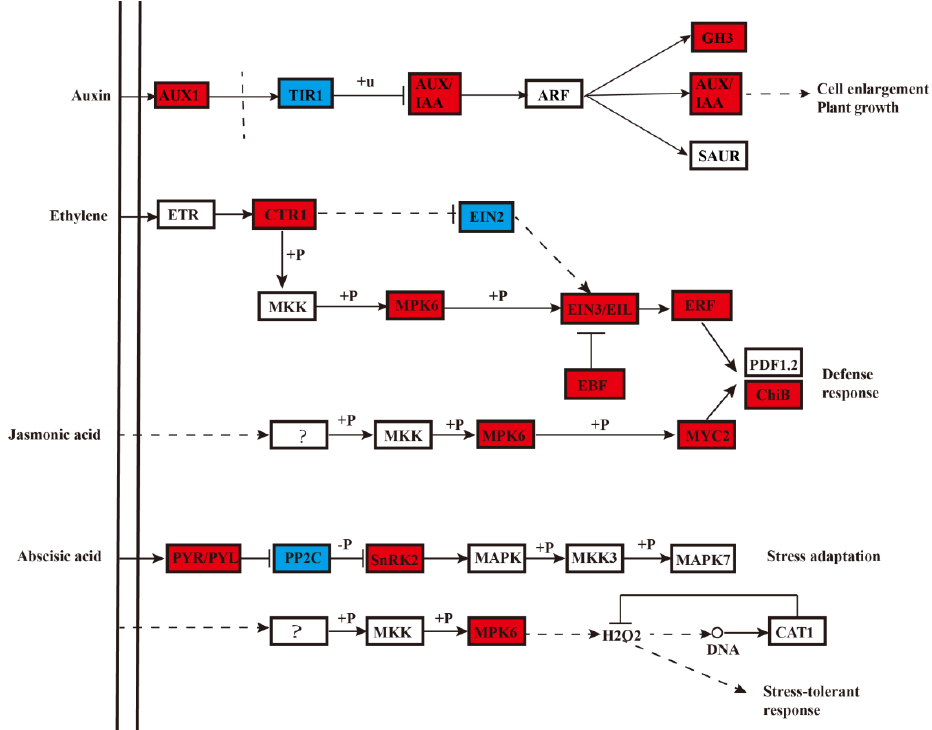
Figure 3. Expression profiles of genes related to hormone signaling. Red boxes indicate genes upregulated after cold storage; blue boxes indicate genes downregulated after cold storage.